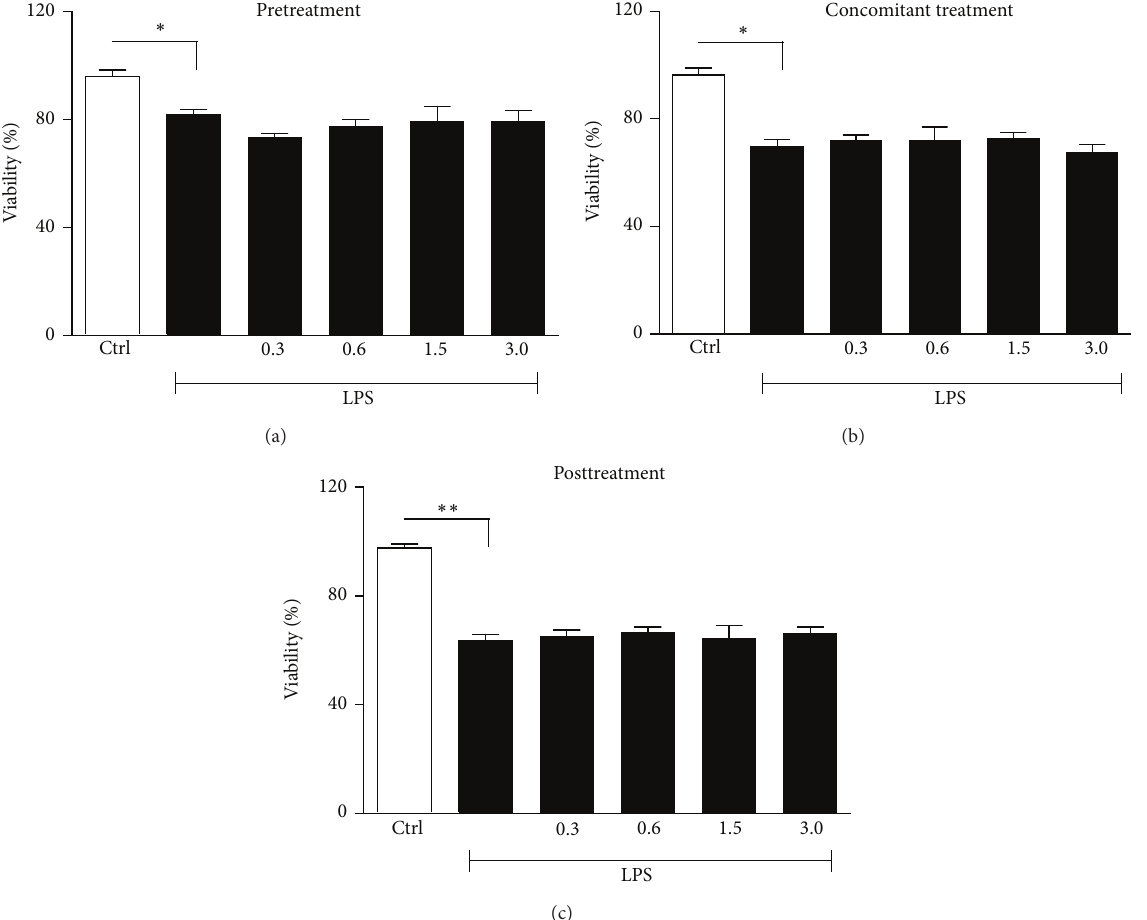
Figure 2: Evaluation of cell viability in HaCaT cells stimulated with LPS (25 𝜇 g/mL) and incubated in pretreatment, concomitant, and posttreatment settings with low (0.3 mg/ 𝜇 L; 0.6 mg/ 𝜇 L) and high (1.5mg/ 𝜇 L; 3 mg/ 𝜇 L) doxycycline doses. (a, c) Cell viability was measured at 48 h in pre- and posttreatment and (b) at 24 h in concomitant treatment. Statistical significance was determined with respect to the viability of nonstimulated cells ( ∗ 𝑃 < 0.05 , ∗∗ 𝑃 < 0.01